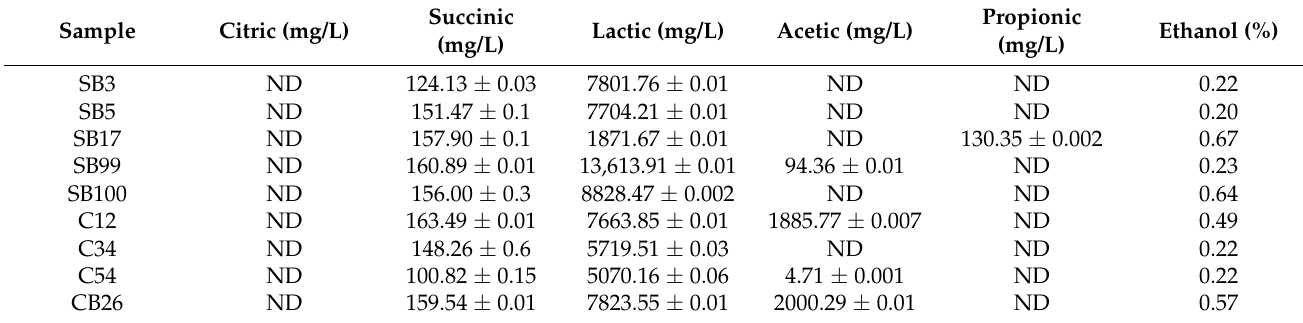
Table 5. Quantification of organic acids produced by LAB isolated from meat products.